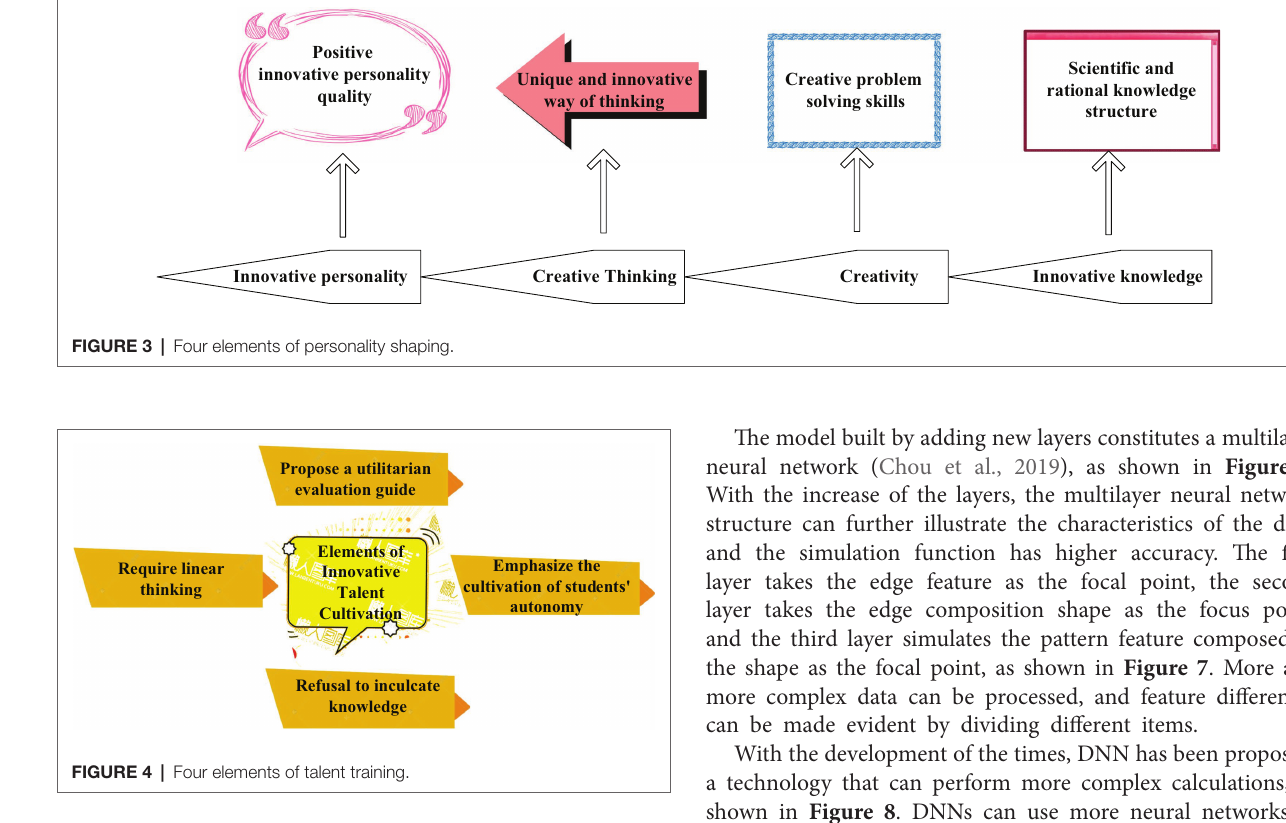
Figure 10 is the structure of the input gate (Tanaka, 2020), which updates valuable data by filtering useless information.